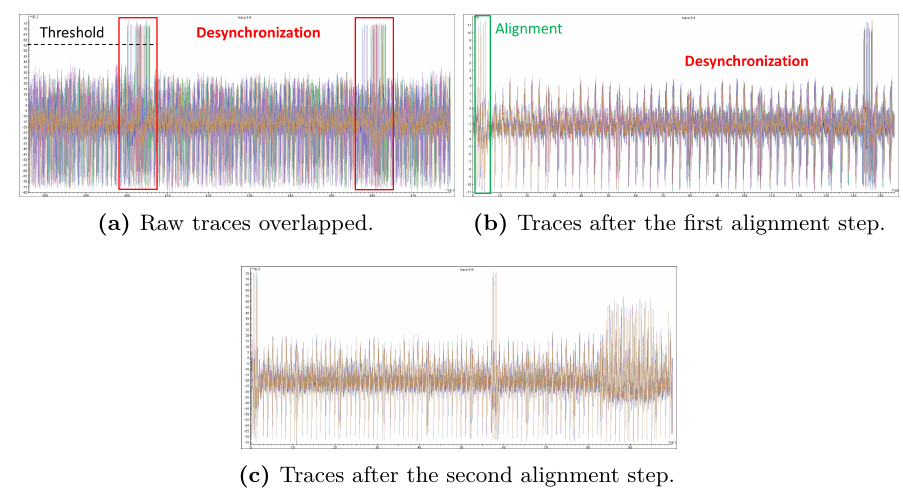
Figure 5: Alignment steps of the MMM pre-processing